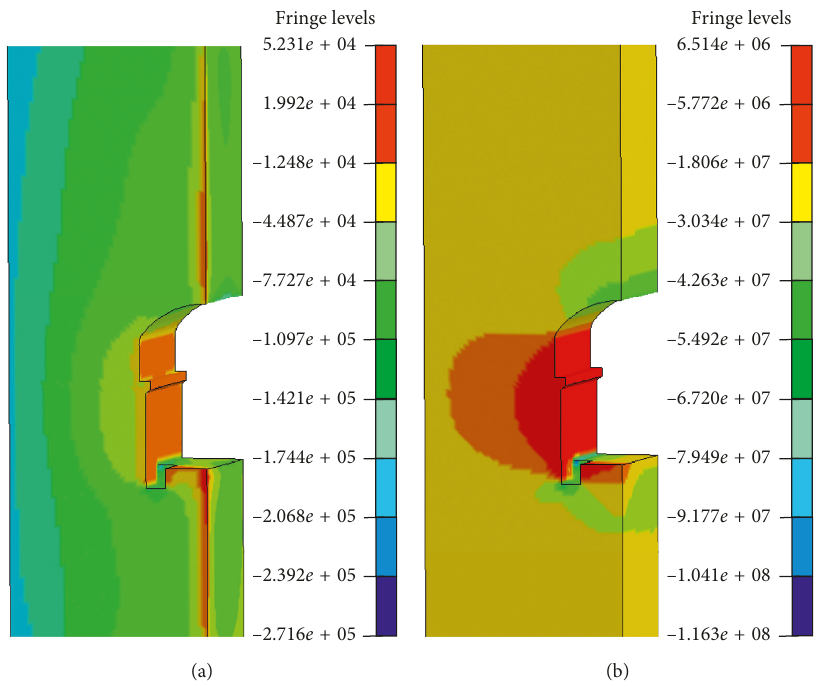
Figure 6: The maximum principal stress nephogram (a) before and (b) after the application of the explosive load.